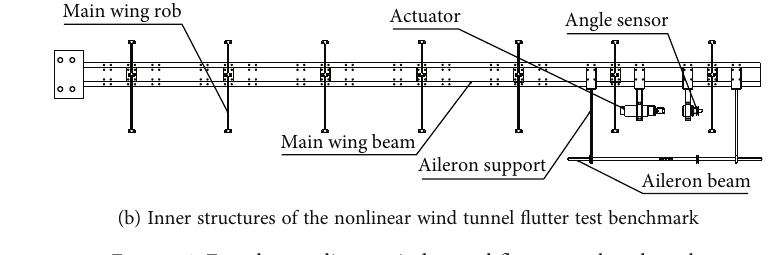
Figure 4: Freeplay nonlinear wind tunnel fl utter test benchmark.